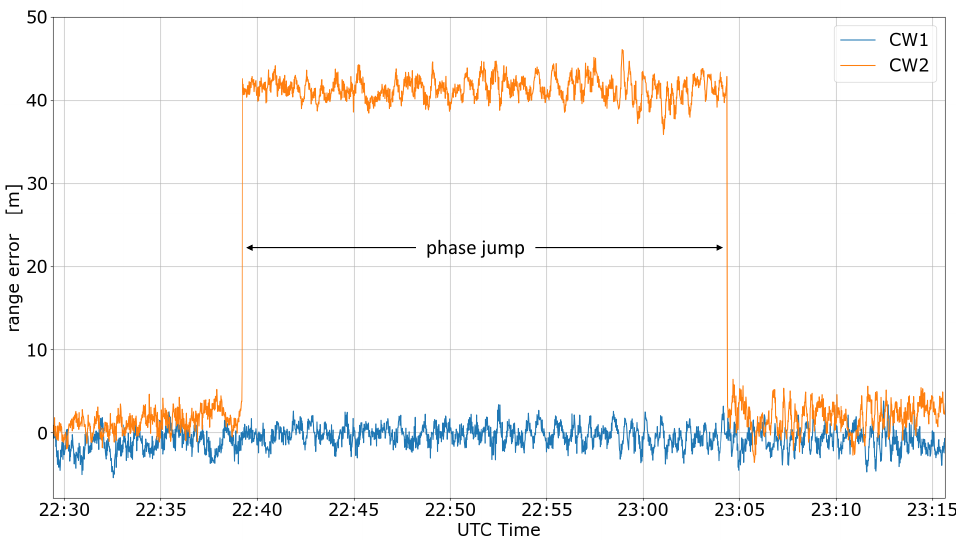
Figure 5. Instabilities of Groß Mohrdorf radio beacon. The phase error in meter is represented for the two CW